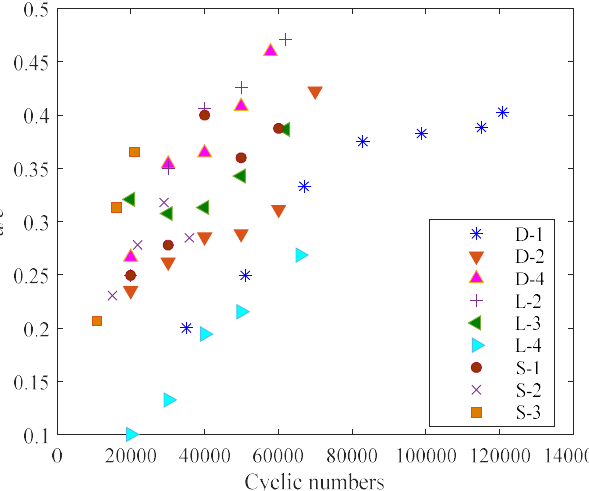
Figure 27. Variation of a/c with cyclic numbers.